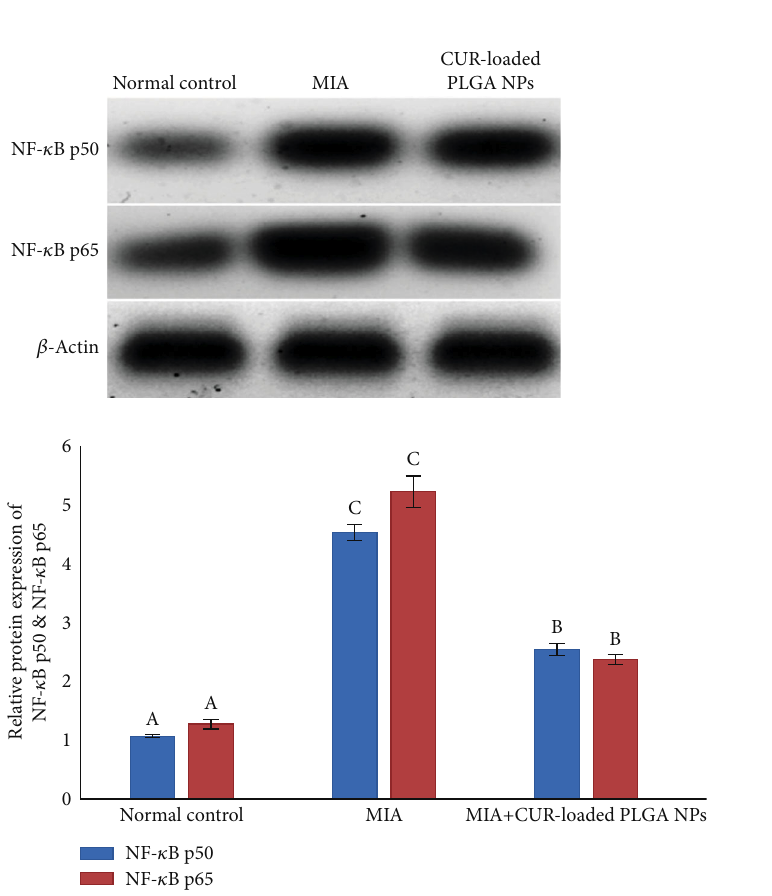
There were six samples in each group, and data are described as means ± SEM . For each parameter, means, which have di ff erent superscript symbols, are statistically signi fi cant at P < 0 : 05 . Table 4: E ff ect of CUR-loaded PLGA NPs on mRNA relative expression of NF- κ B, iNOS, and type II collagen of MIA-induced OA rats. Groups